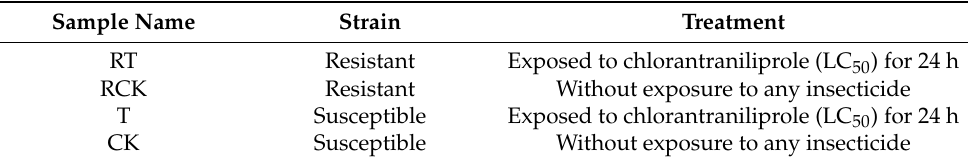
Table 2. Sample information of Plutella xylostella RNA-Seq.